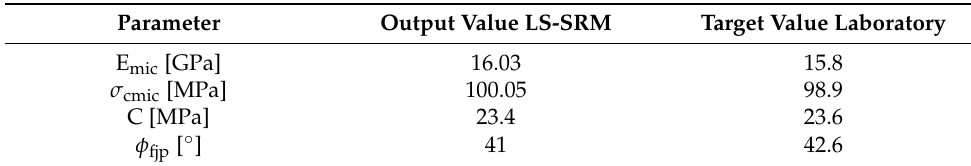
Table 5. Results of the intact rock calibration.